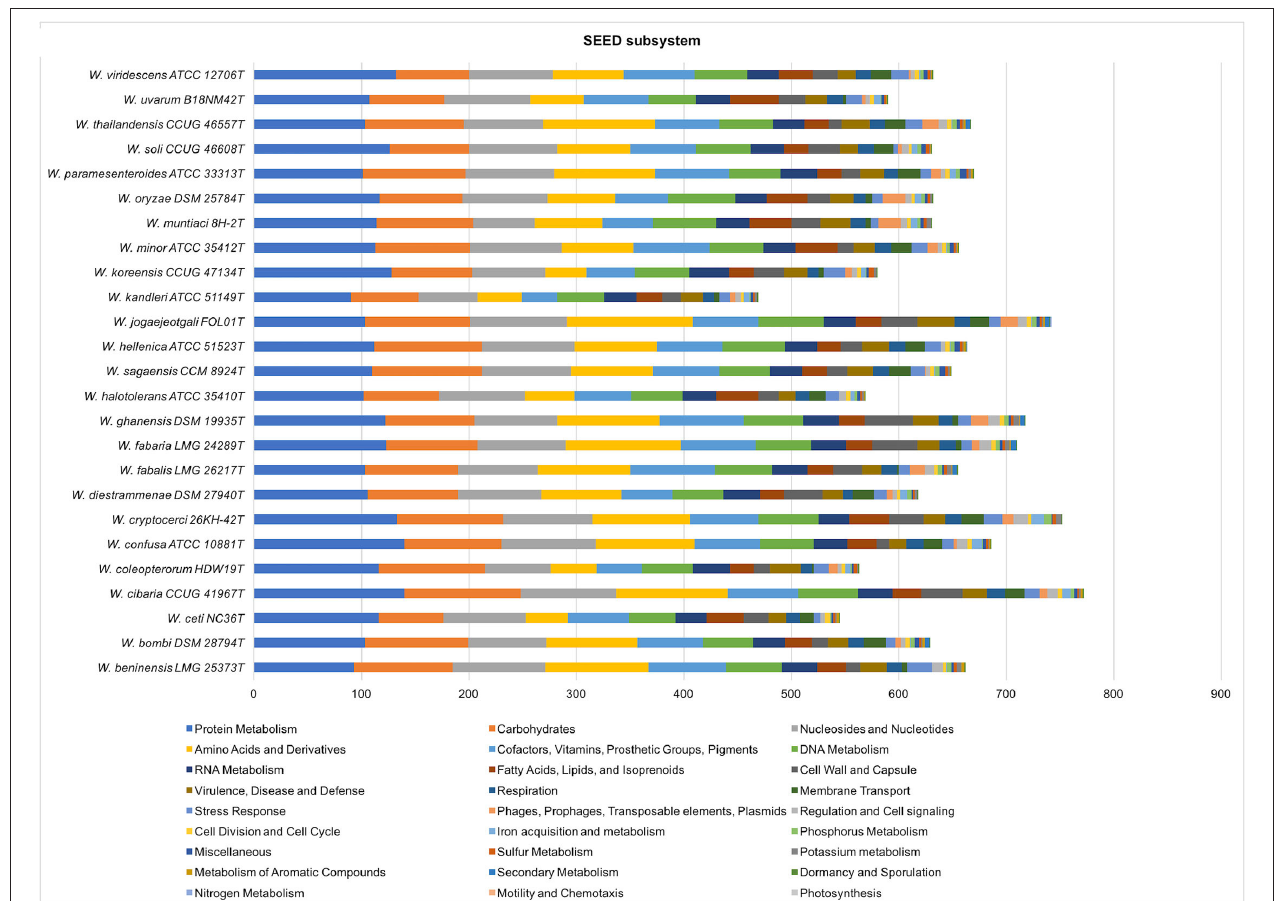
FIGURE 5 | Comparative analysis of SEED subsystem features in Weissella species. Genes annotated by RAST were assigned to functional categories and grouped into subsystems. Colored bars indicate the number of genes assigned to each category.